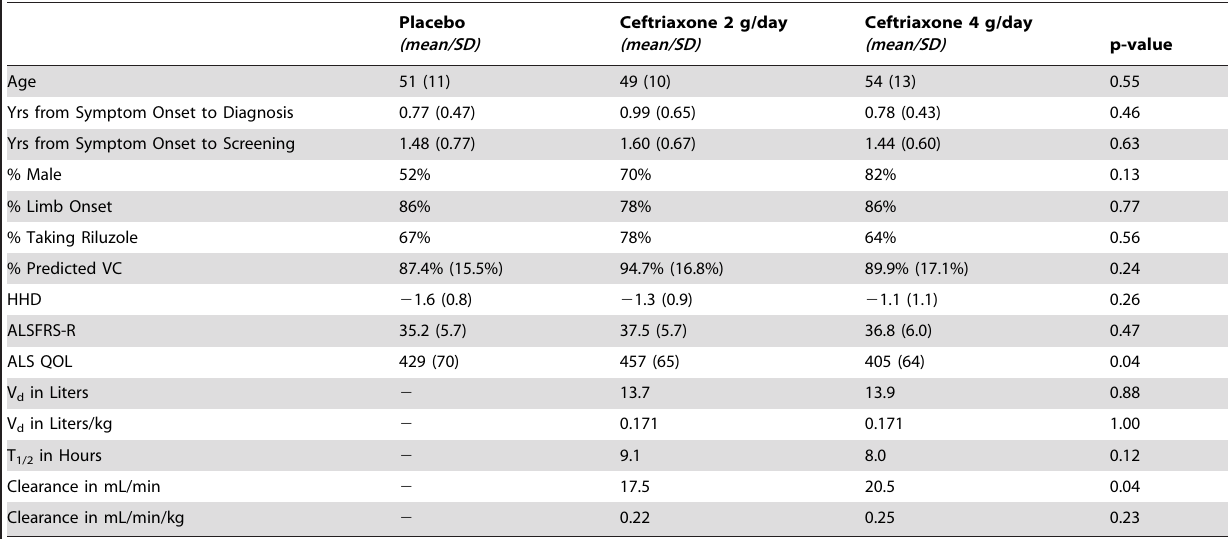
Table 1. Demographics.